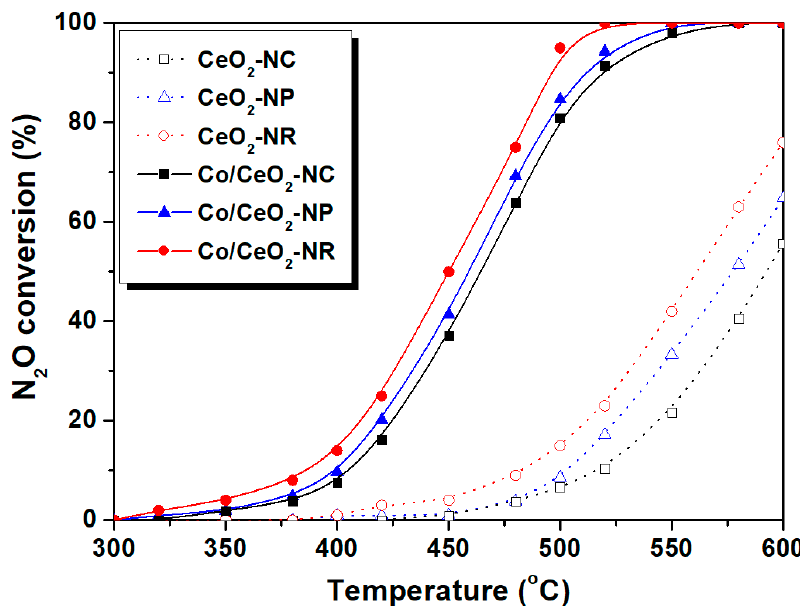
Figure 10. N 2 O conversion as a function of temperature for bare CeO 2 and Co/CeO 2 with nanorod (NR), nanopolyhedra (NP), and nanocubes (NC) morphology. Reaction conditions: 1000 ppm N 2 O, GHSV = 40,000 h − 1 .